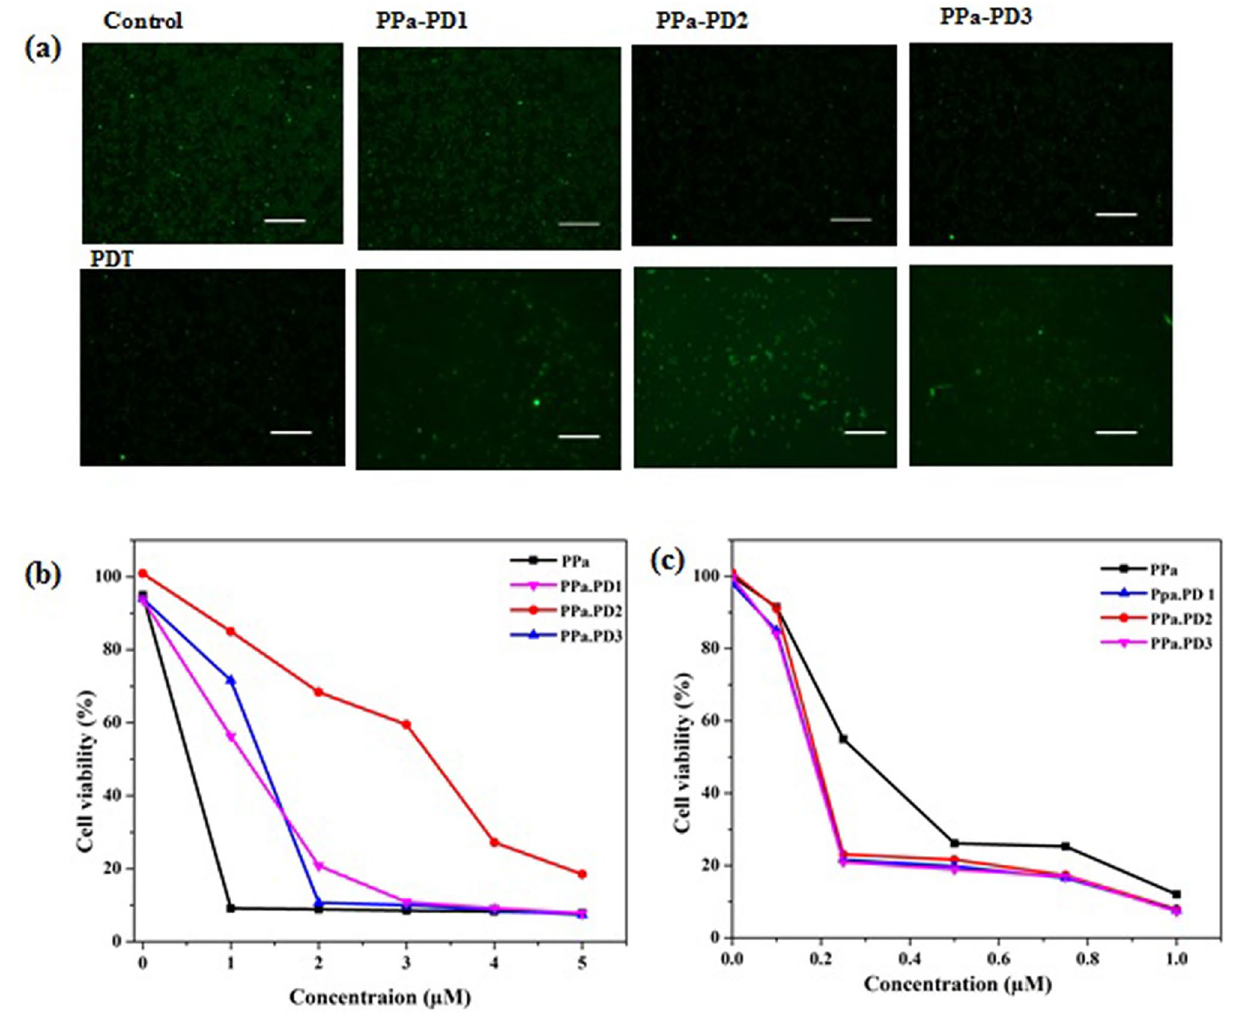
Figure 6. ( a ) Cell viability of Eca-109 after PDT. ( b ) MTT assay dark toxicity, ( c ) Phototoxicity. Scale bar 200